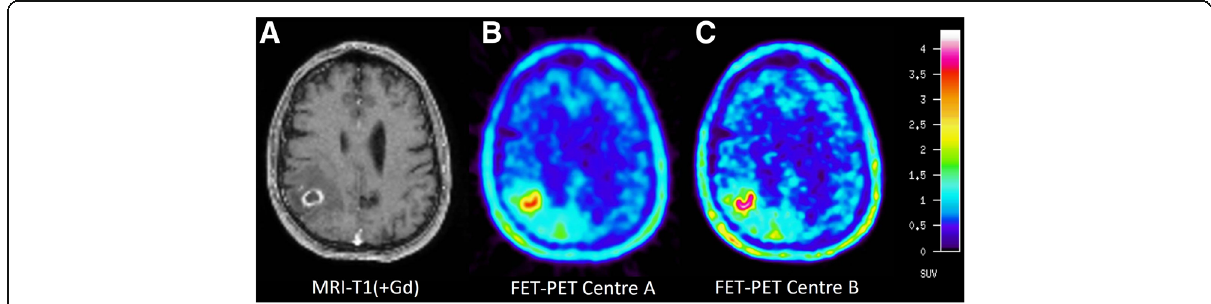
Fig. 1 Glioblastoma in the right parietal lobe. Contrast-enhanced T1-weighted MRI ( a ) shows a ring-enhancing lesion. FET PET image based on the method of centre A ( b ) shows lower noise but the image based on the method of centre B ( c ) shows a sharper demarcation of the metabolically active tumour